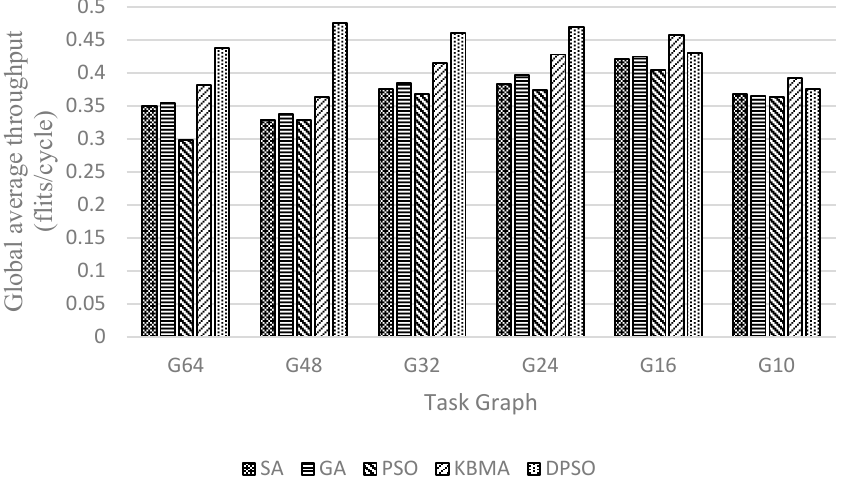
Figure 8. Throughput at different sizes of random task graphs on 4 × 4 × 4 3D mesh structure.